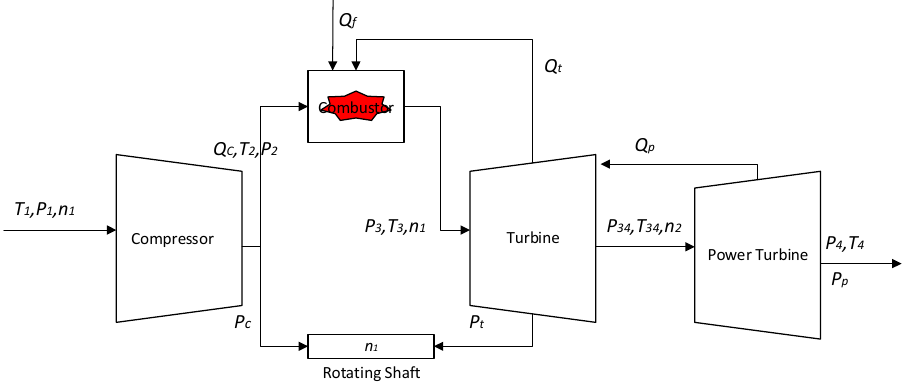
Figure 2. Modeling flowchart based on the modular modelling method for gas turbine.